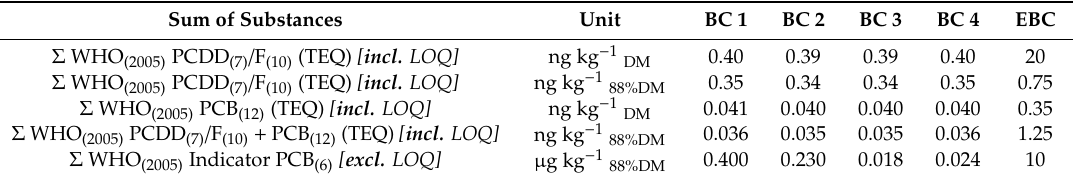
Table 5. Condensed values for the polychlorinated dibenzo- p -dioxins and dibenzofurans (PCDD / Fs), polychlorinated biphenyls (PCBs), and dl-PCBs in four BCs plus EBC threshold 3 . Sum of Substances Unit BC 1 BC 2 BC 3 BC 4 EBC